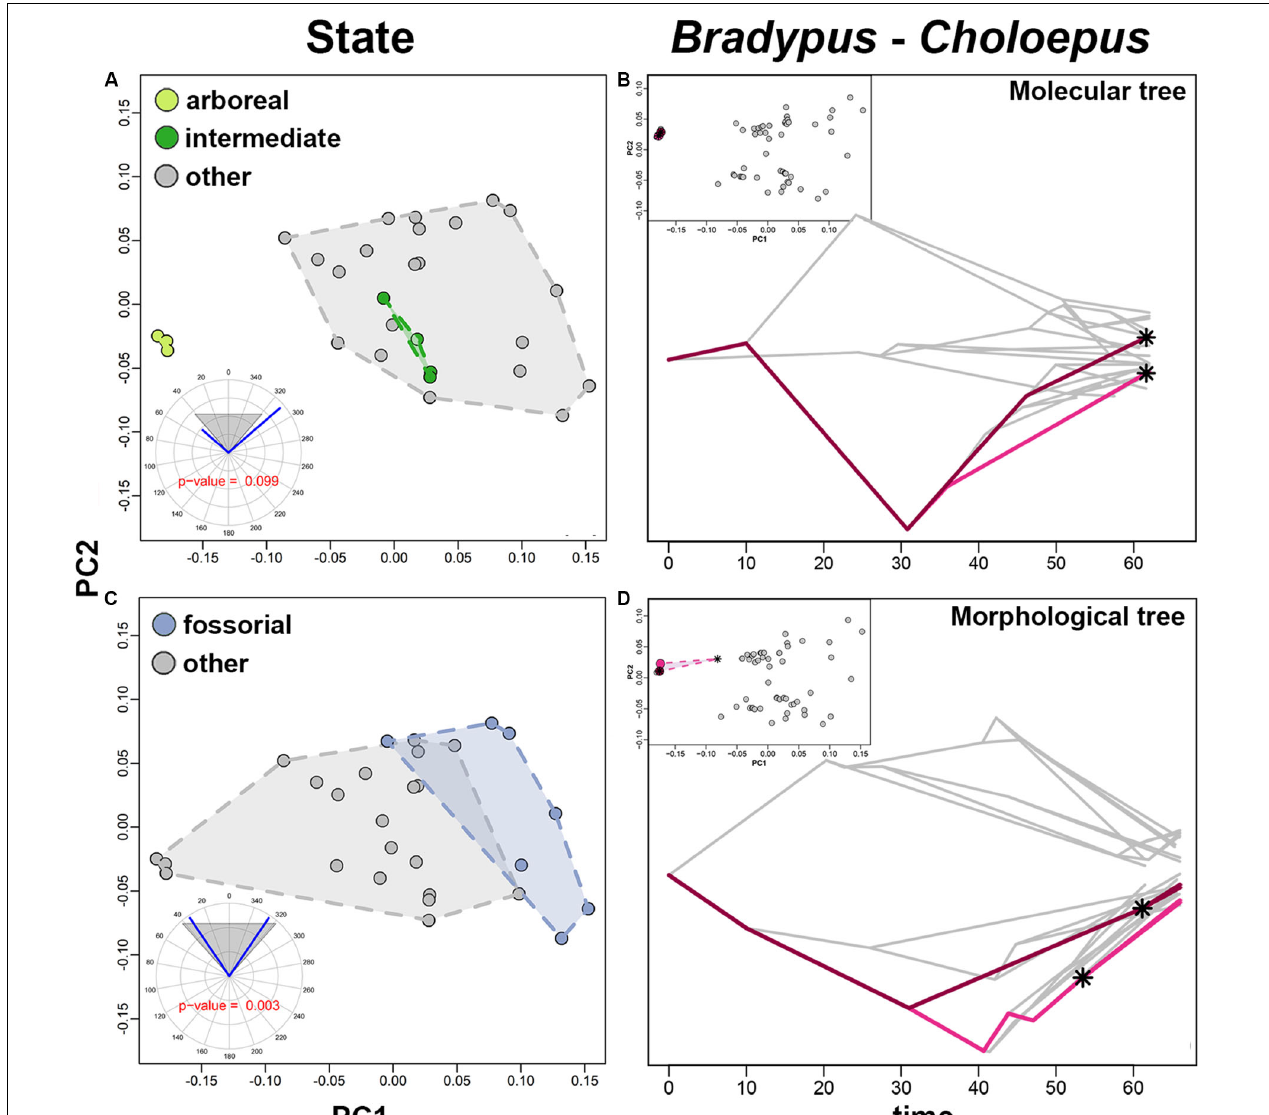
FIGURE 5 | (A,C) PC1 vs. PC2 scatter plot. Convex hulls are colored according to different states. Circular plots represent the mean angle between states, the gray area is the random angle range. (B,D) Traitgram plot with colored branched representing convergent clade. PC1 vs. PC2 scatter plot are produced, convergent clades are color coded. In both, traitgram and PC1 vs. PC2 scatter plot asterisks represent the ancestral phenotypes of the individual